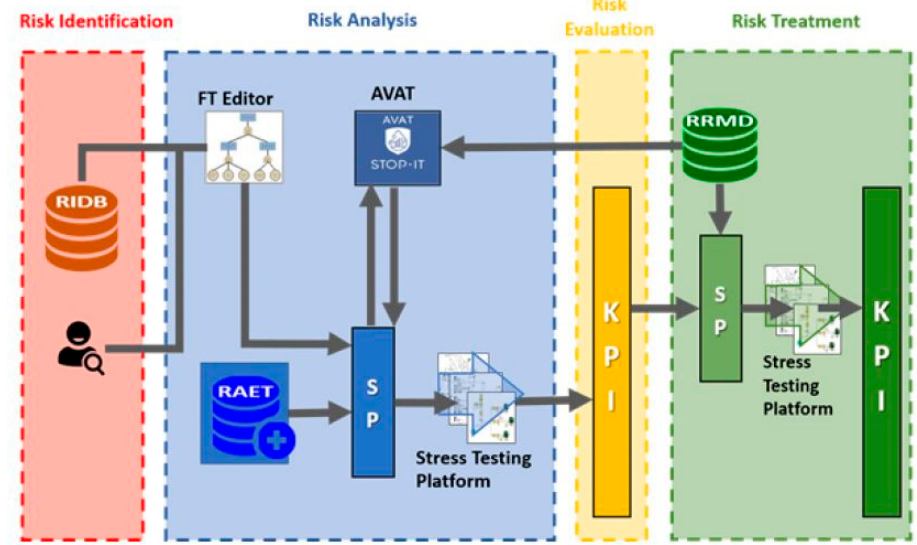
Figure 1. Logical interconnections amongst the different tools within RAET [16].